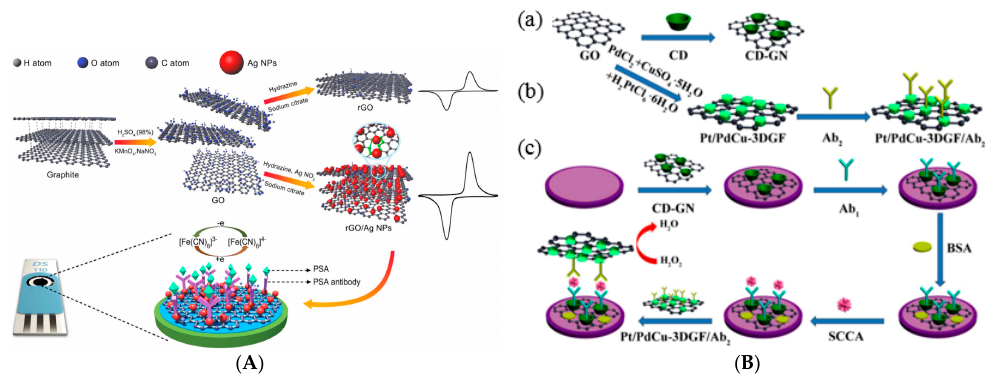
Figure 11. ( A ) RGO and RGO/AgNPs for PSA detection, with Fe(CN) 63 − /4 − as diffusing redox probe. Reprinted from [63], Copyright 2017, with permission from Elsevier; ( B ) Cyclodextrin-modified graphene ( a ); functionalization by Pt/PdCuNPs and Ab 2 ( b ); and ( c ) global immunosensing scheme. Reprinted from [65], Copyright 2016, with permission from Elsevier.